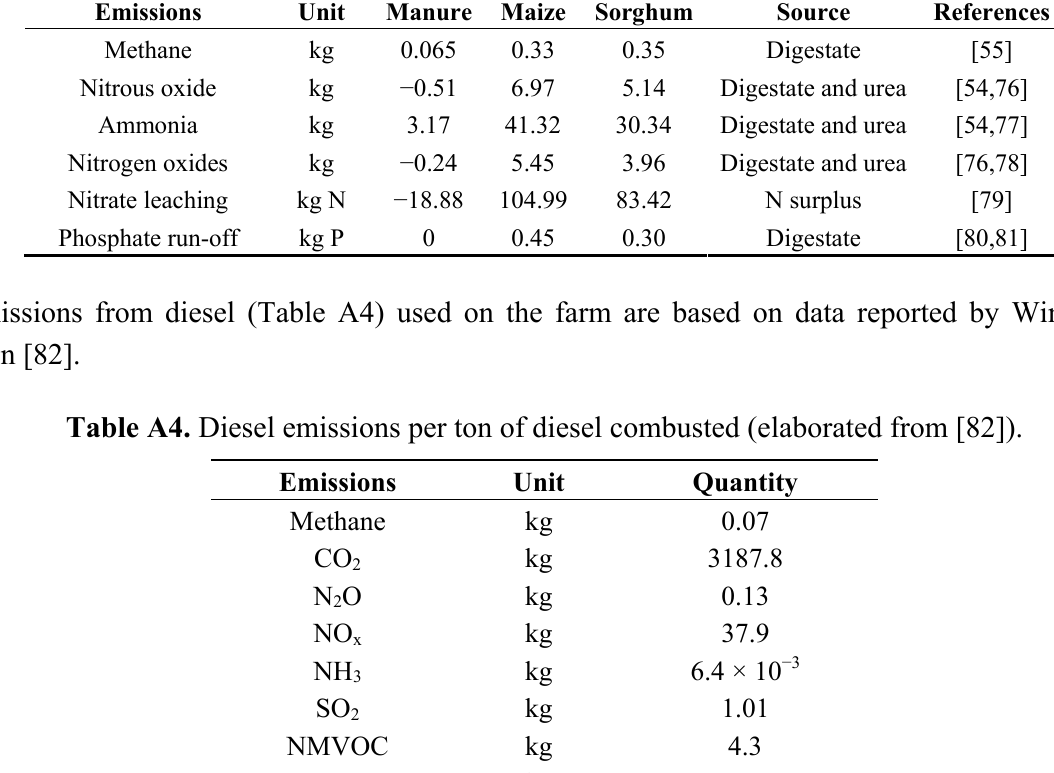
Table A3. Field emissions (per hectare) due to the application of mineral and organic fertilisers. Emissions Unit Manure Maize Sorghum Source Methane kg